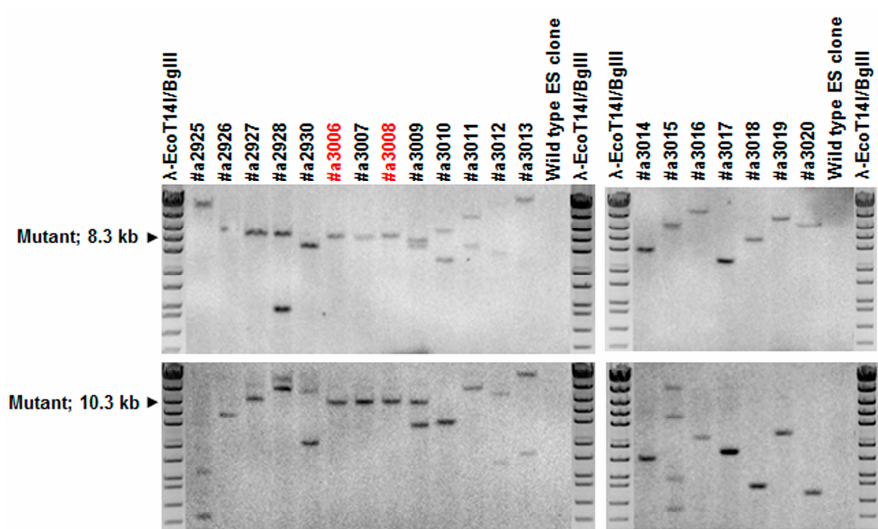
Figure 8. Southern blot analysis using neo probe. 5 ′ EcoRI-digested (target mutant band is 8.3 kb in upper panel) and 3 ′ NdeI-digested (target mutant band is 10.3 kb in lower panel) DNA were analyzed. #a3006 and #a3008 clones (in red) were verified to have one inserted copy of the targeting vector.